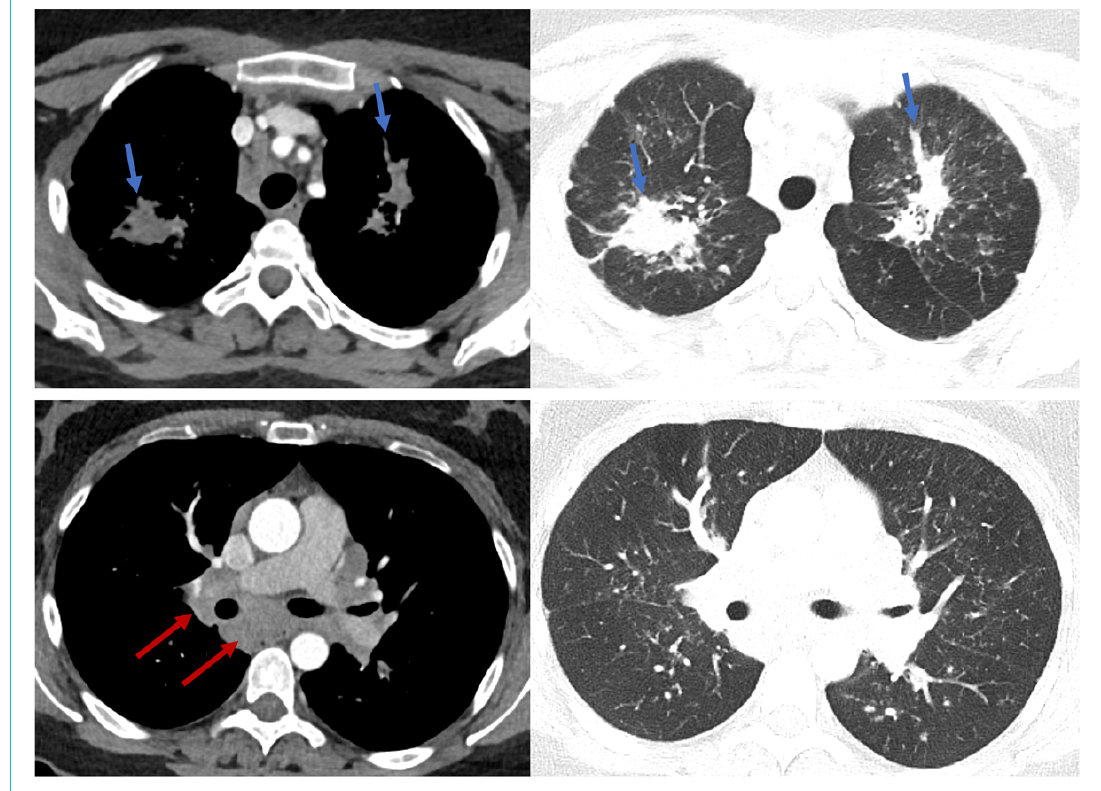
Figure 2: Axial chest computed tomography (CT) images of a 41-year-old female with histologically proven sarcoidosis. Upper panel: exten- sive, bilateral pulmonary consolidation along peri-bronchovascular bundle (blue arrow) and multiple micronodular changes in upper lobes. Lower panel: extensive mediastinal and bi-hilar lymphadenopathy (red arrow). Clearly less nodular changes in lower lobes (courtesy Dr D. Franzen,